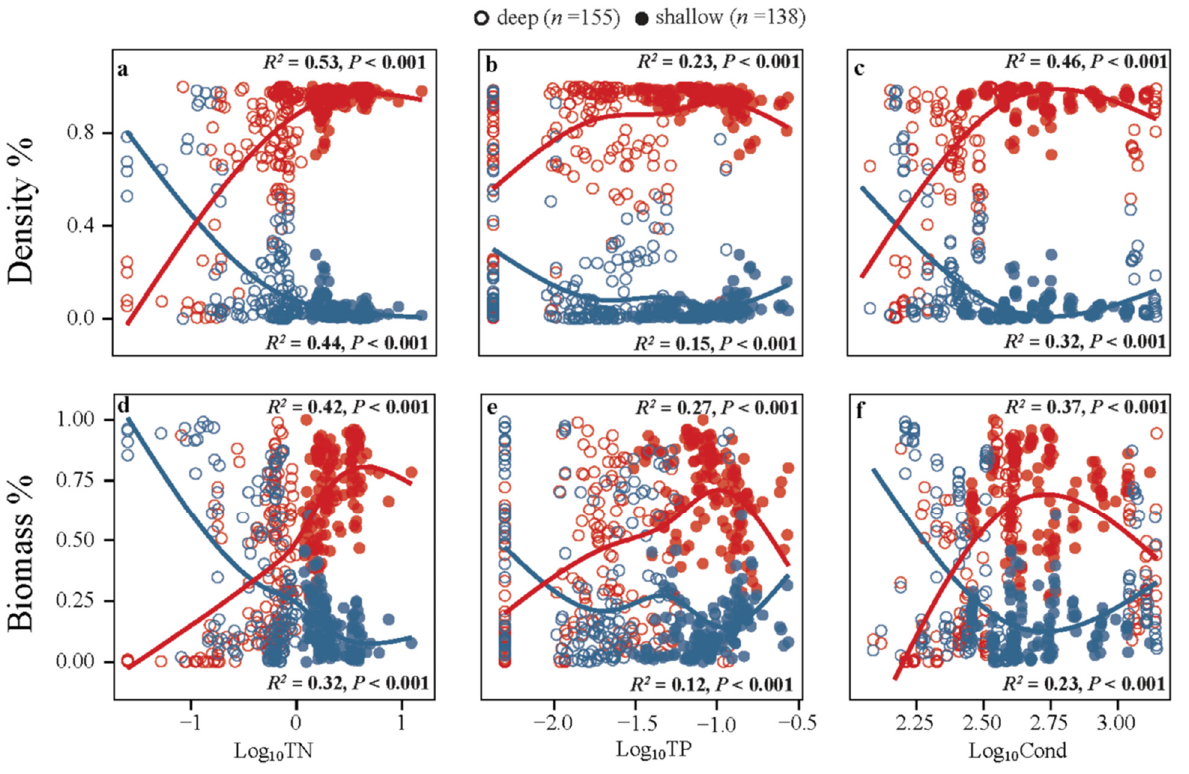
Figure 4. Generalized additive model measurements of the percentage share relationships of TN, TP, and Cond with density ( a – c ) and biomass ( d – f ) of cyanophyta (red) and chlorophyta (blue) in the studied lakes. See Figure 3 and Table S1 for model parameters used in the classification of deep and shallow lakes.